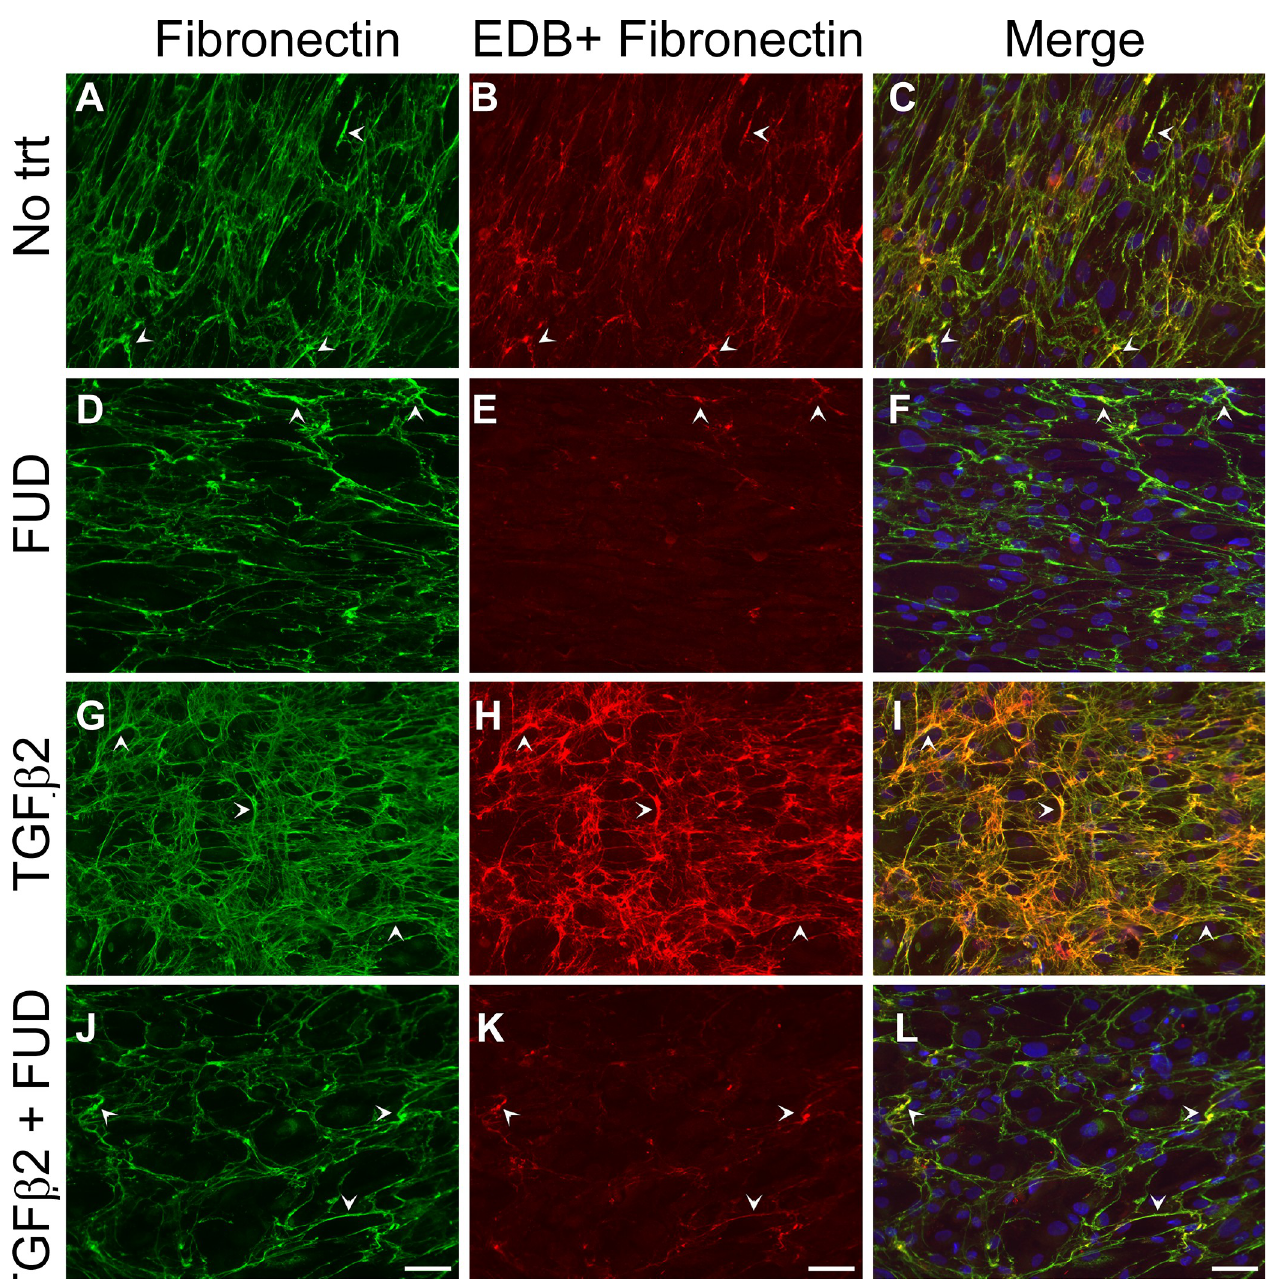
Fig 7. Recombinant FUD prevented TGF β 2 induced increase in fibronectin and EDB+ fibronectin fibrillogenesis. Confluent HTM cultures (N25TM-8) were untreated (A-C) or treated with 2 μ M FUD (D-F), 2ng/ml TGF β 2 (G-I) or both FUD and TGF β 2 (J-L) for 4 days. Cells were then fixed and double labeled with polyclonal fibronectin sera (FN, A, D, G and J) or an antibody (BC-1) that recognizes the EDB domain of fibronectin (B, E, H and K). Arrowheads in merged fibronectin and EDB+ fibronectin images (C, F, I and L) indicate where fibronectin and EDB+ fibronectin labeling coincide. Similar results were seen with one other cell strain. Bar = 50 μ